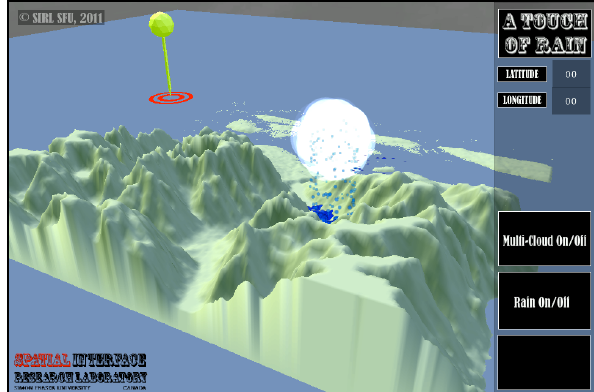
Figure 3. An early prototype of A Situated Touch of Rain in single user mode with a DEM of Vancouver’s North Shore mountains. The user’s real-time location in the real world is indicated by the yellow stick. Note that when this screen capture was made, we were not physically present in the area covered by the DEM, but on campus – to the Southeast.